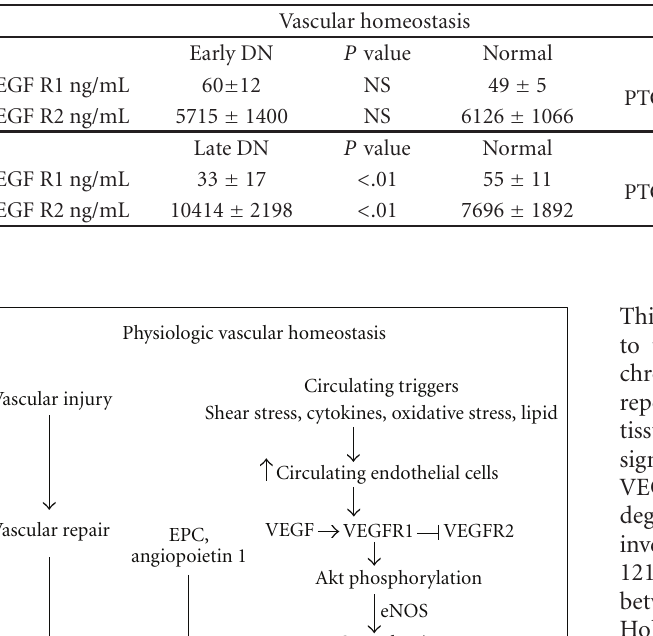
Table 2: A predominant role of VEGFR2 correlates with PTCF reduction in late stage of DN.